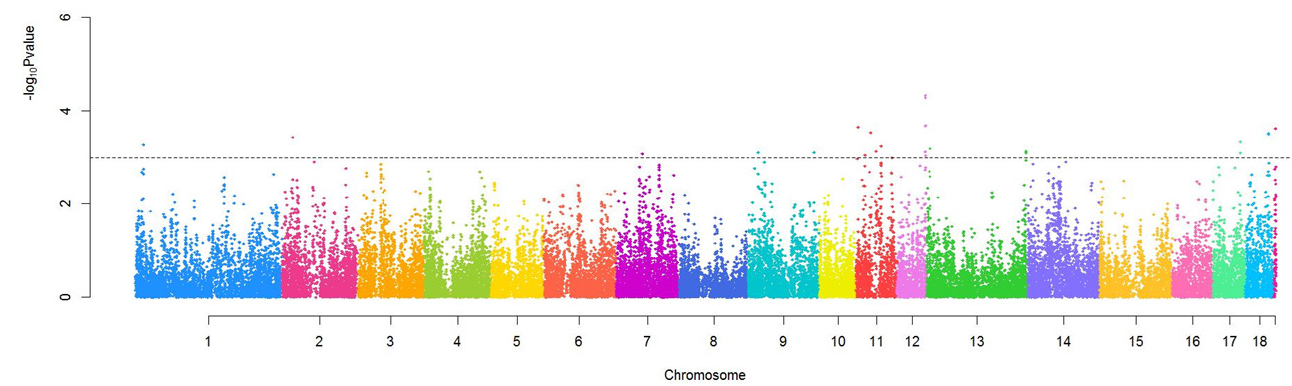
Figure 1. The statistical significance values of the association of single nucleotide polymorphisms (SNPs) across 18 autosomal chromosomes and the X chromosome with intramuscular fat content (IMF) plotted as –log10 p values. The horizontal dotted line indicates the cutoff p = 0.01.